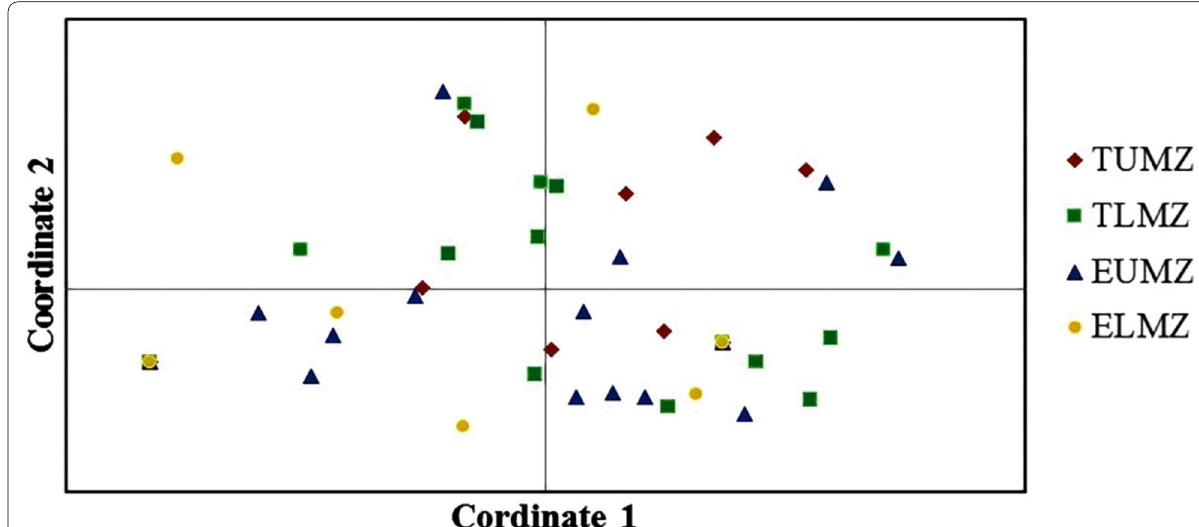
Fig. 5 Principal coordinate analyses (PCA) of indigenous bradyrhizobia isolates based on restriction banding patterns. The percentage variations for the first two coordinates (1) 25.2% and (2)